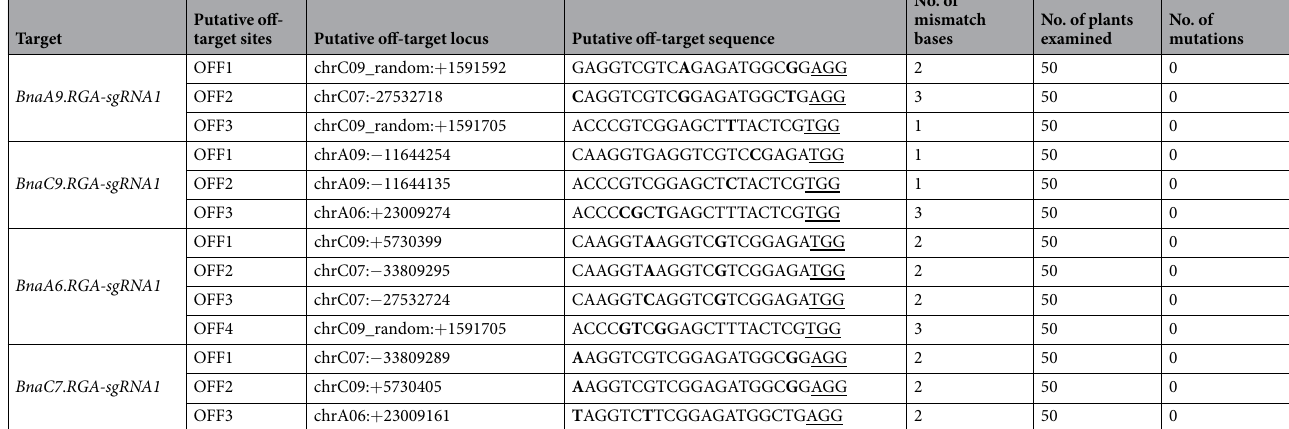
Table 5. Detection of mutations at the putative CRISPR/Cas9 off-target sites in the T0 and T1 generation. The PAM motif (NGG) is indicated by underlines; mismatched bases are shown in red